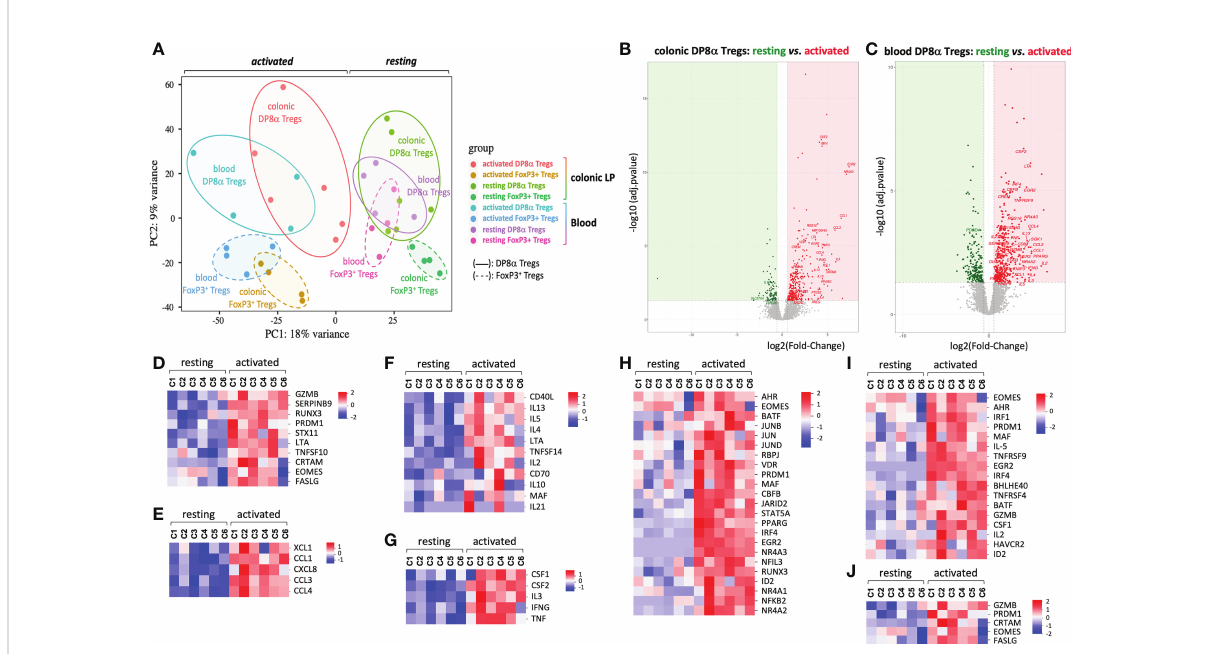
FIGURE 2 Principal component and DEG analyses. Transcriptomic comparison of human DP8 a and FoxP3 + Treg clones isolated from the colonic lamina propria and blood from 4-6 subjects, activated or not. (A) Principal component analysis. (B , C) Log2 fold-change of average expression values for genes expressed by resting versus activated DP8 a clones: colon-derived (B) blood derived (C) . (D-I) Heat-maps showing normalized expression of selected DEGs between resting and activated colon-derived DP8 a clones. Genes involved in cytotoxicity (D) , encoding chemokines (E) , involved in B cell help (F) , encoding cytokines (G) , encoding TF (H) , genes of the Tr1 signature (I) and genes corresponding to a CD4-CTL signature (J) are